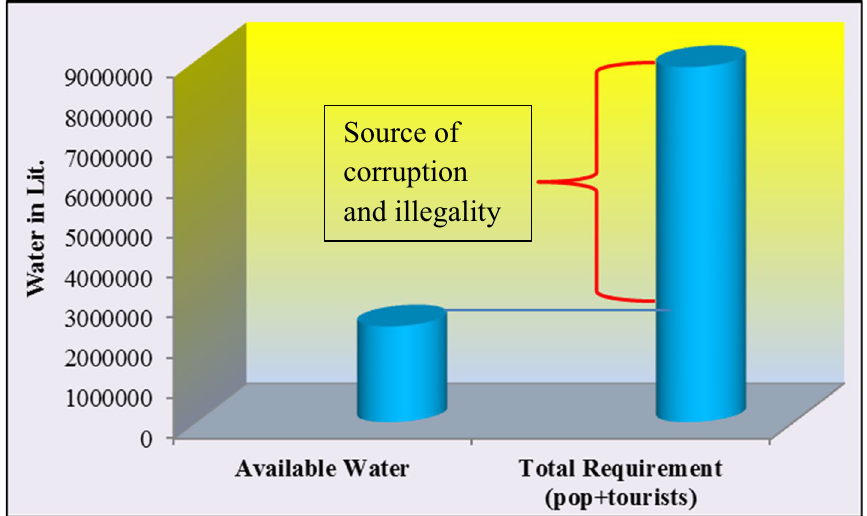
Fig. 9 Gap of water availability and water